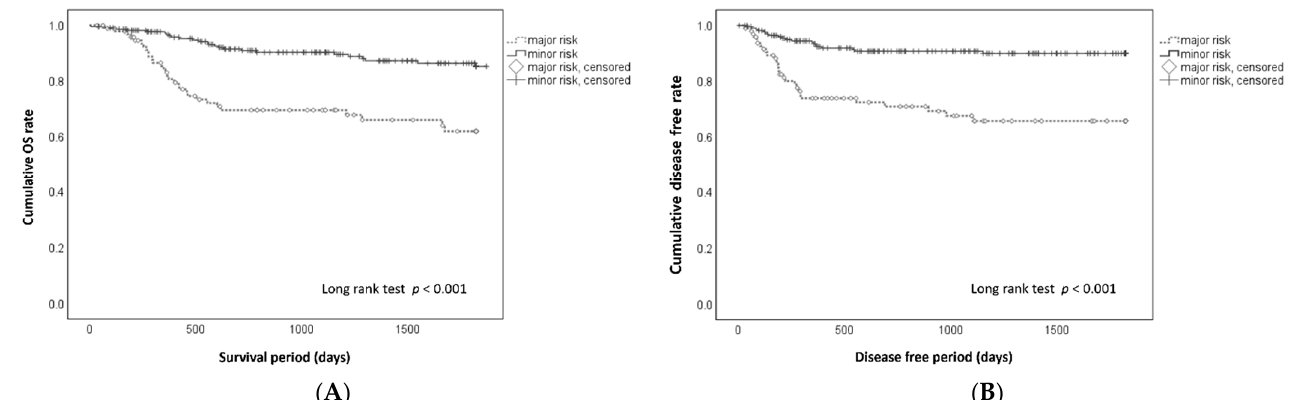
Figure 2. ( A ). Cumulative overall survival (OS) rate in patients with oral squamous cell carcinoma in the major and minor risk groups. The 5-year OS rates were 61.9% in the major risk group and 85.2% in the minor risk group, with significantly lower OS in the major risk group ( p < 0.001). ( B ). Cumulative disease-free (DF) rate in patients with oral squamous cell carcinoma in the major and minor risk groups. The 5-year DF rates were 65.7% in the major risk group and 89.9% in the minor risk group, with significantly lower DF in the major risk group ( p < 0.001).